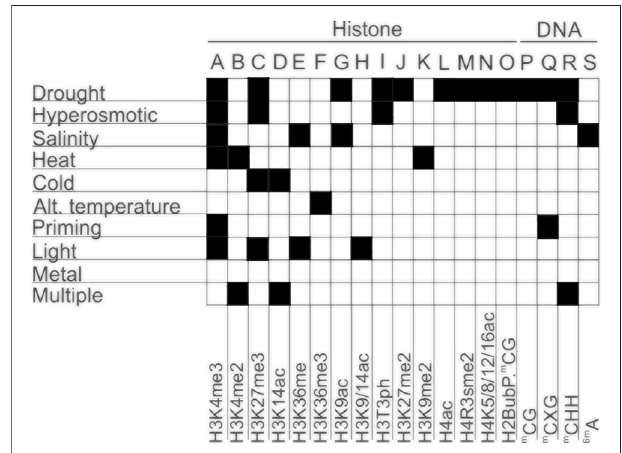
FIGURE 1 | Deciphering the alphabet of epigenetic responses to the environmental stresses in plants. Different types of epigenetic modi fi cations in response to different abiotic and biotic stresses. A-O — Histone modi fi cations; P-R — Cytosine methylation; S — Adenine